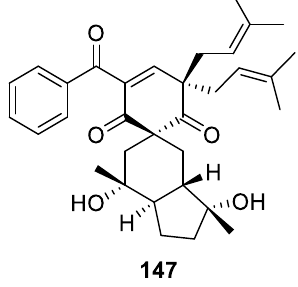
Figure 69. Hyperbeanol C isolated from Hypericum beanie .